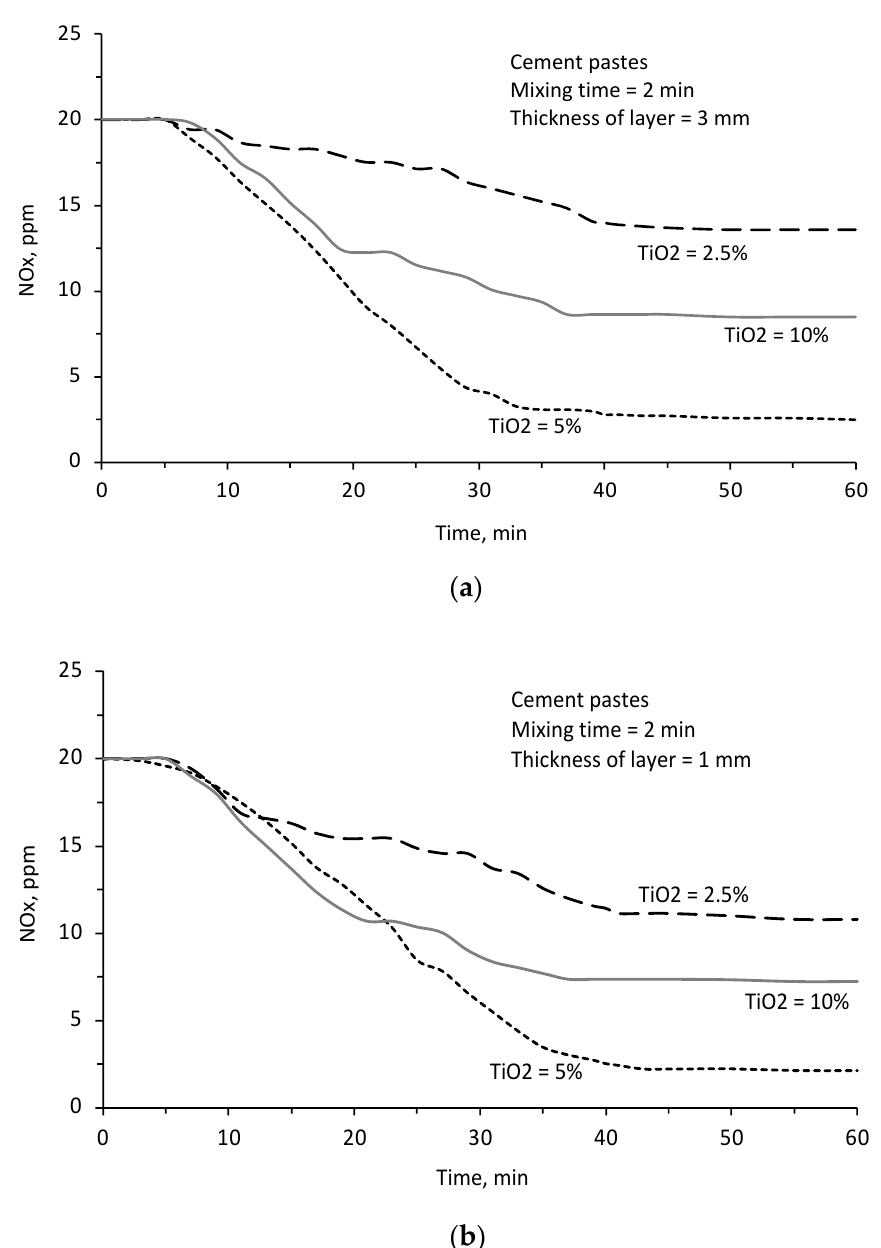
Figure 10. Variations of NOx concentrations at reactor outlet as a function of time for 3 mm ( a ) and 1 mm ( b ) cement slurry thicknesses.